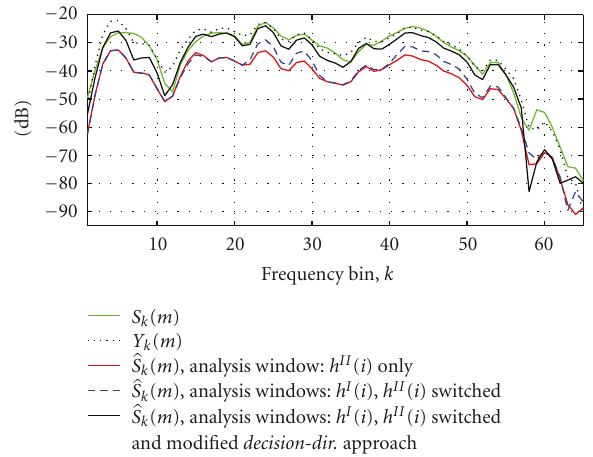
Figure 20: Spectra of clean, S k ( m ), noisy (speech-shaped additive noise), Y k ( m ), and estimated clean speech, (cid:12) S k ( m ) of the phoneme [ p ] in “poach.” The estimated clean speech is obtained by Wiener filtering using a spectral analysis based on either the asymmetric long window only, h II ( i ), or based on the window set h I ( i ) and h II ( i ) from Figure 1. If the window set is used the window decision is based on the nonstationarity decision. The thin solid black line shows the result if additionally to the switched window set the proposed modification of the decision-directed approach is applied. Frame amplification (cf. 4.3) is not shown here. The above spectra have been created using a 128-point DFT and Hann windowed data (sampling frequency f s = 16kHz).